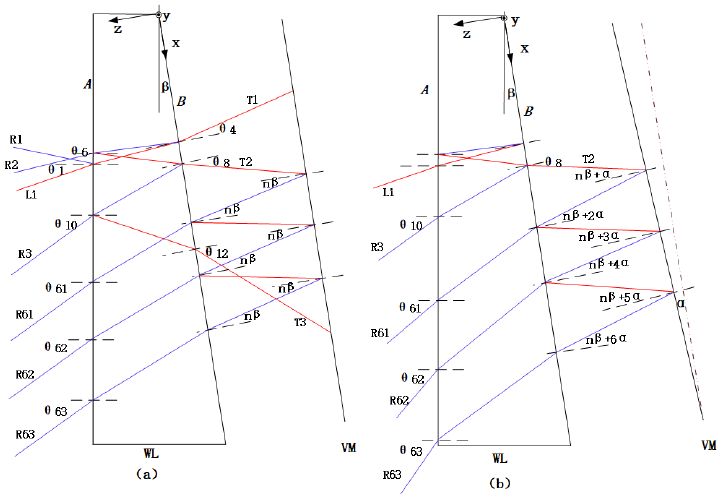
Figure 2. Light propagation between the light wedge (WL) and the vibrating mirrors (VM). ( a ) VM parallel to plane B of the WL; and ( b ) VM rotated counterclockwise by an angle of α